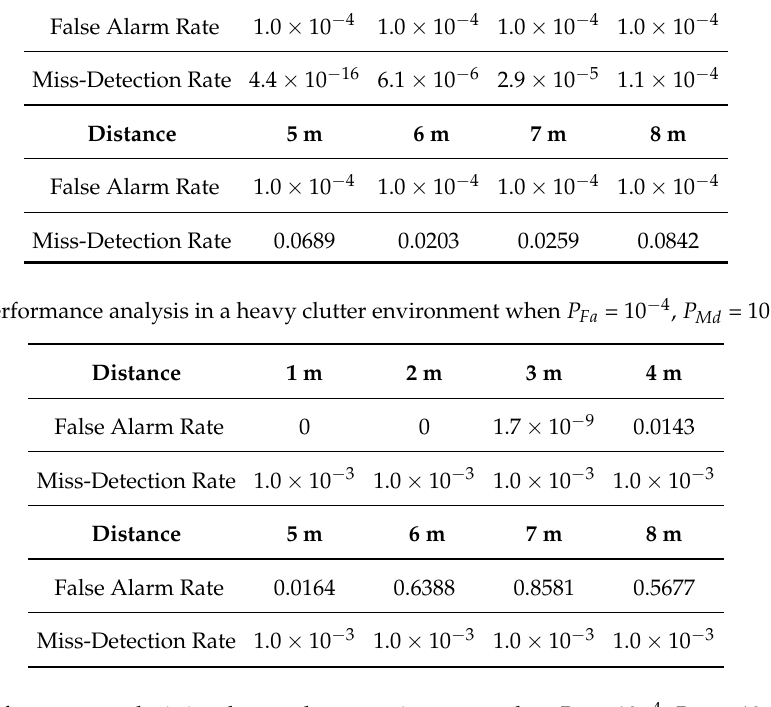
Table 7. Performance analysis in a heavy clutter environment when P Fa = 10 − 4 , P Md = 10 − 3 , α = 0.3.